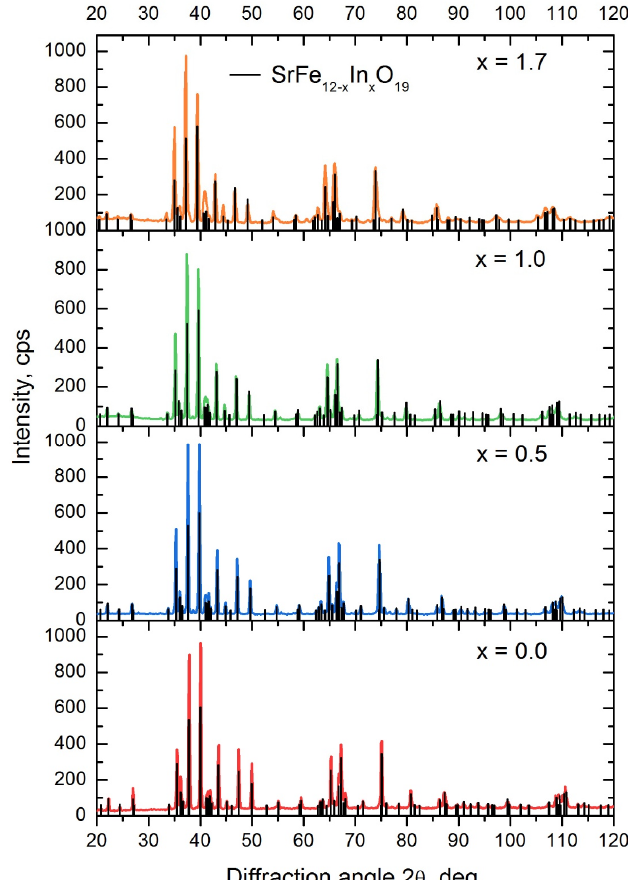
Figure 4. XRD patterns of SrFe 12 − x In x O 19 samples obtained by the citrate method and annealed at 1200 °C for 1 h.